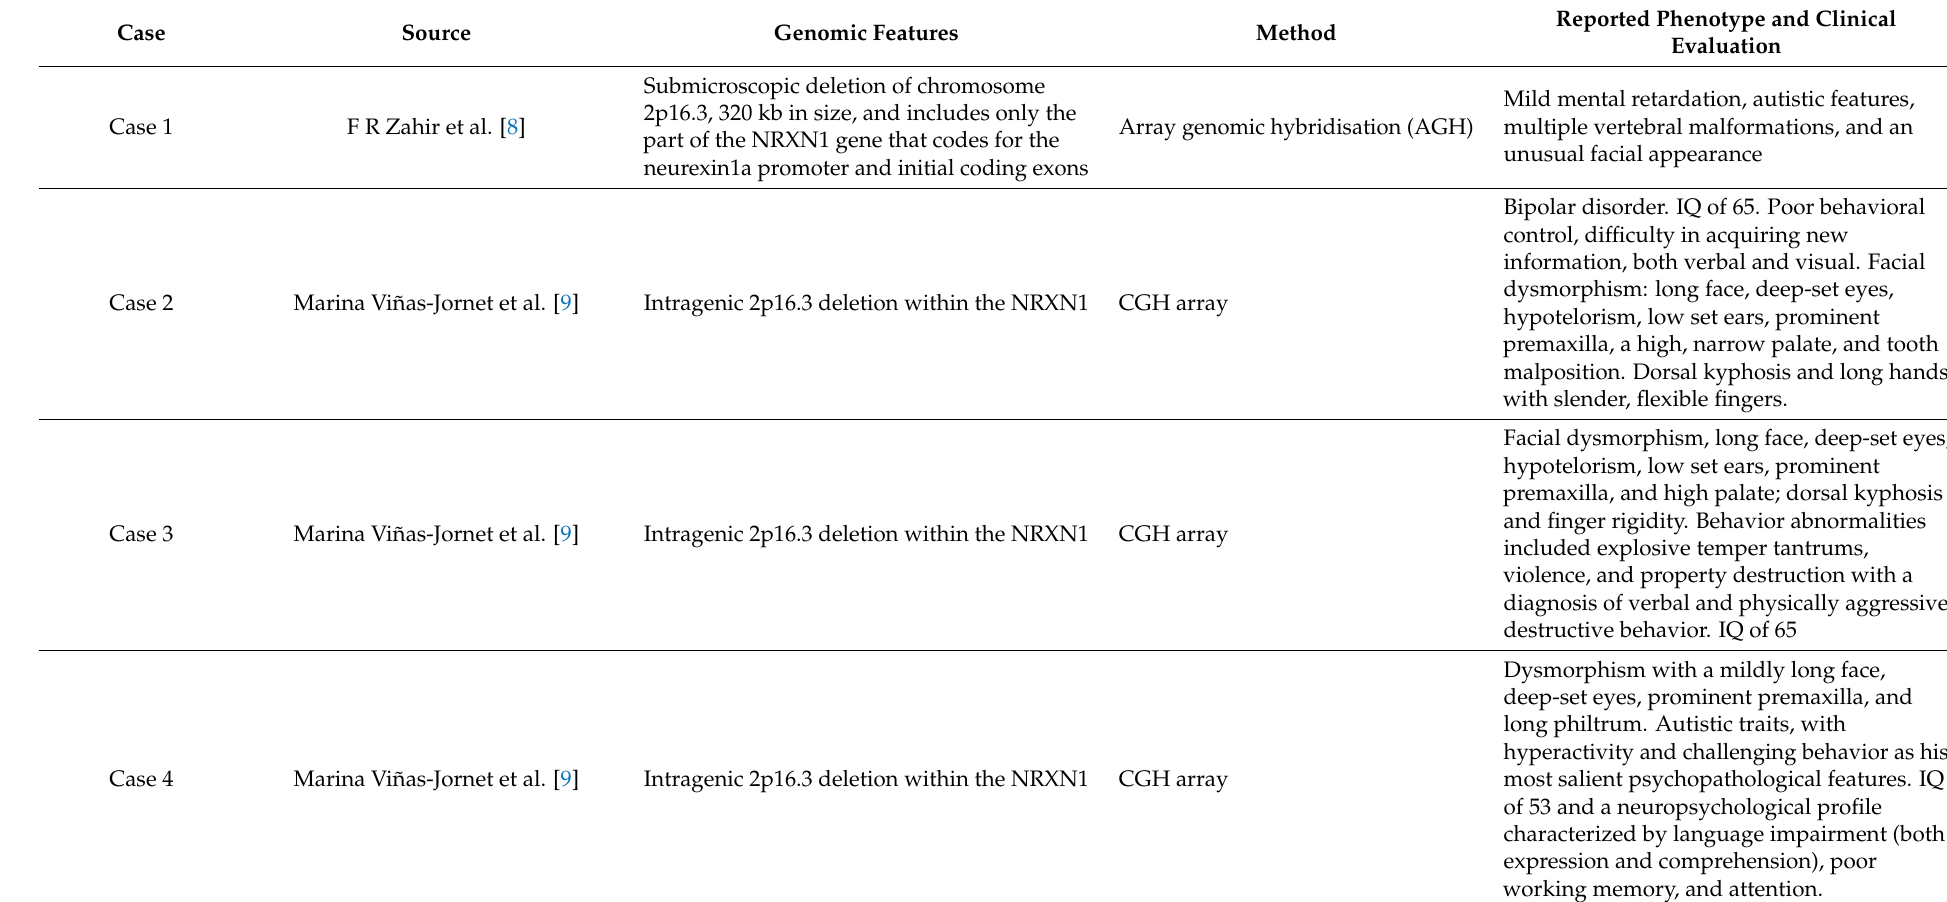
Table 2. Details of other reported cases with genomic aberrations expected to cause NRXN1 loss of